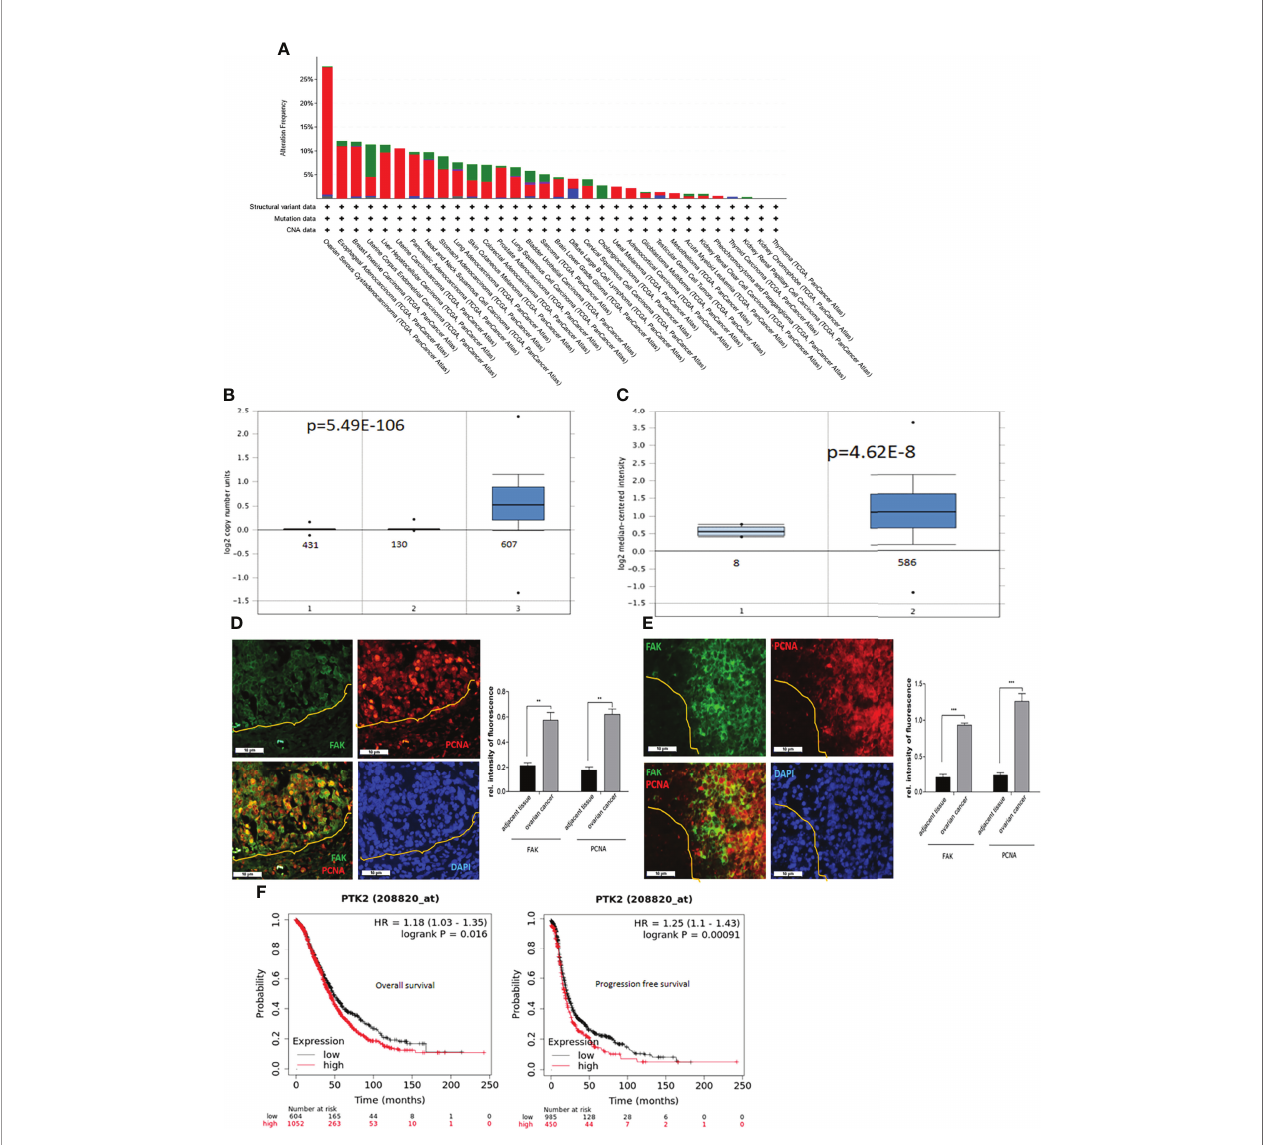
FIGURE 1 | PTK2 is highly expressed in OC and correlated with OC patient poor survival. (A) PTK2 alteration frequencies in OC compared to other cancer types in TCGA. (B) PTK2 copy numbers were shown in 607 OC compared to 431 normal blood and 130 ovaries in Oncomine. (C) PTK2 expression is signi fi cantly upregulated in 586 OC compared to that in 8 normal ovaries in Oncomine. (D, E) Immuno fl uorescent staining of FAK (green) and PCNA (red) in HGSC (D) or PDX (E) sections. Nuclei were counterstained with DAPI (blue). Fluorescent intensity was quanti fi ed by Image J. (F) Survival analysis of OC patients from Kaplan-Meier database. Both overall and PFS survival rates were analyzed from 1656 OC patents (* p <0.05; ** p <0.01; *** p